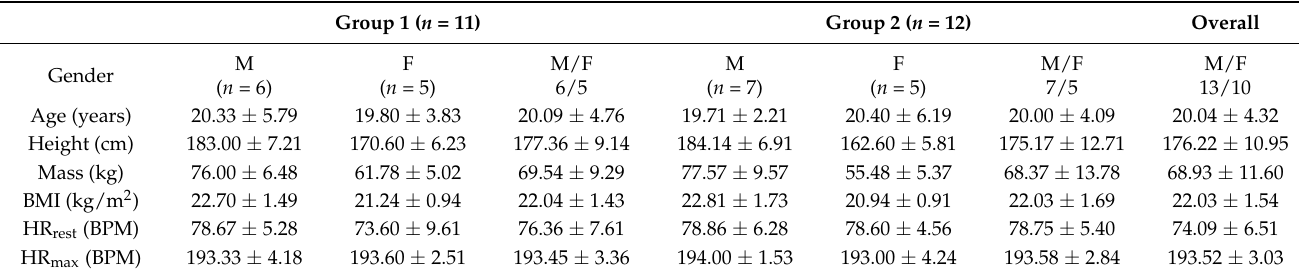
Table 1. Demographics of participants.